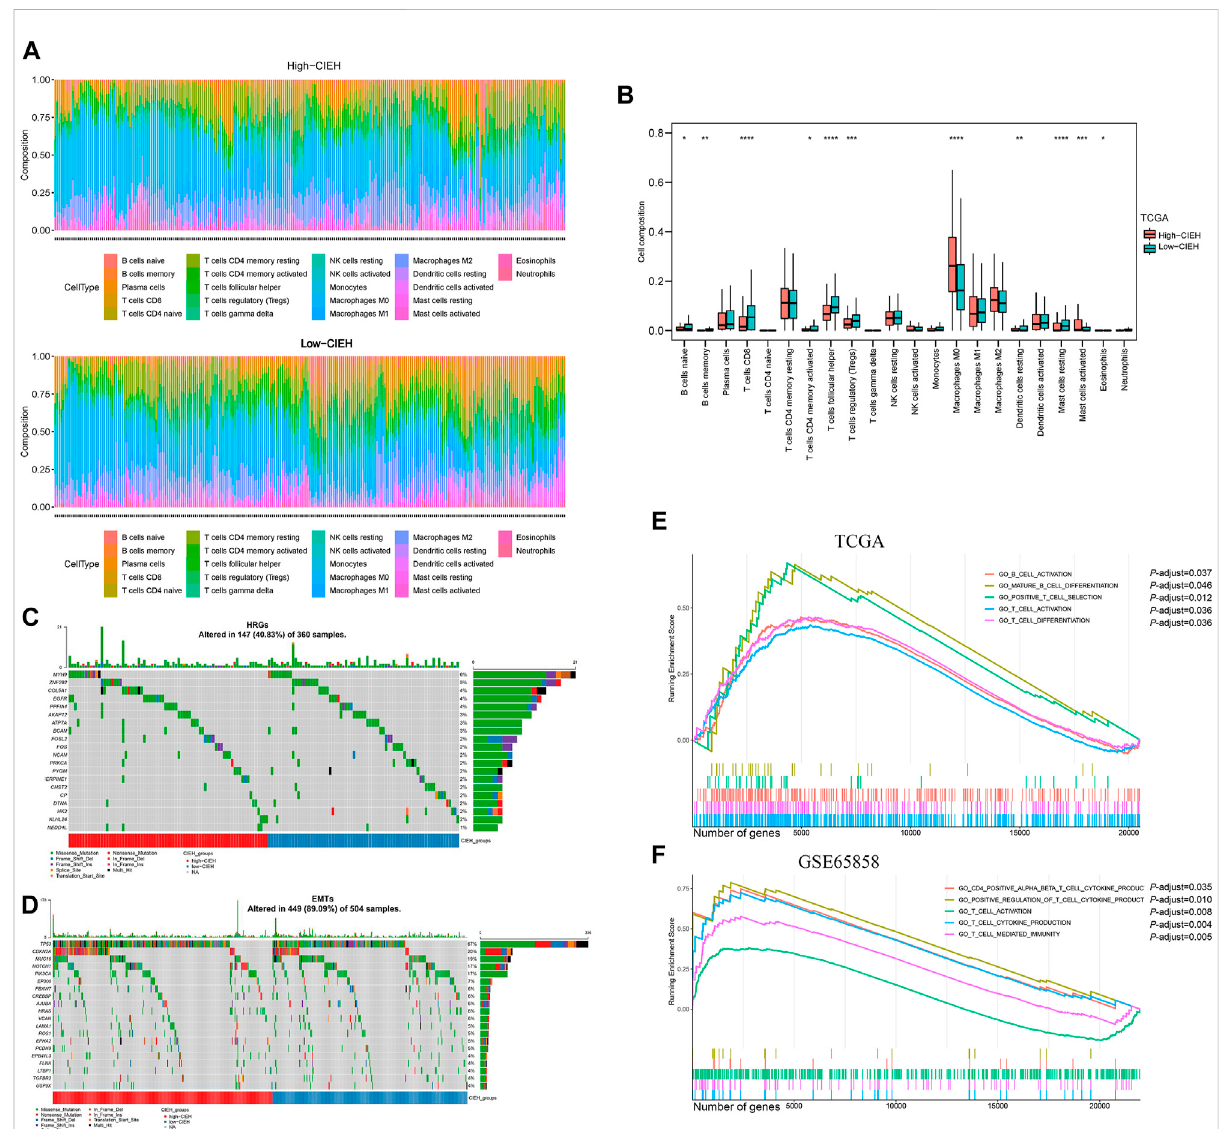
FIGURE 4 Immune function of the CIEH. CIBERSORT assessed the difference in immune in fi ltration between high and low comprehensive index of EMT and hypoxia (CIEH) groups. (A) . The difference between the proportion of immune cells in groups with a high and low CIEH. (B) . Comparing the immune cell composition of high and low CIEH groups. (C,D) . Mutation difference analysis of HRGs and EMTs between the high and low CIEH groups. (E,F) .GOenrichmentbetweenthehighandlowCIEHgroupswasanalyzedinTCGAandGSE65858.TheXscaleisthenumberofgenes. The short vertical line represents the position of the corresponding gene in the sequence list in the enrichment